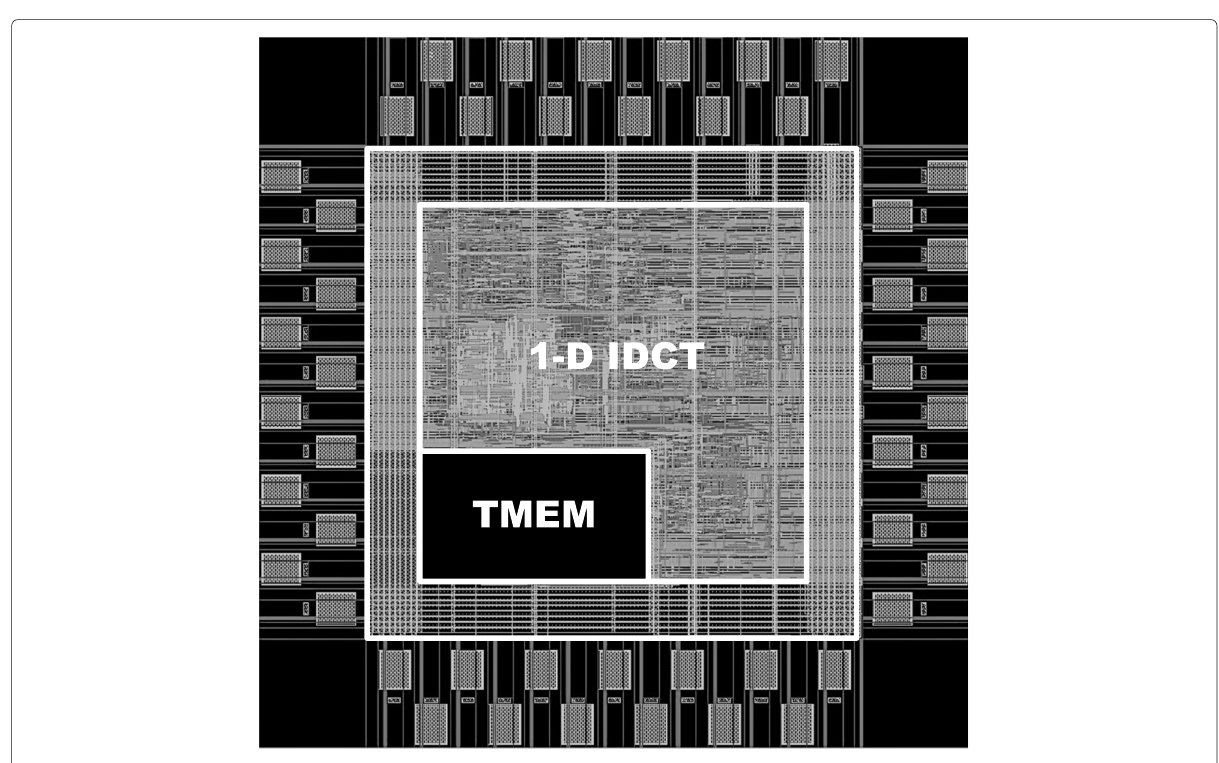
Fig. 8 Chip layout of the proposed 2-D IDCT core